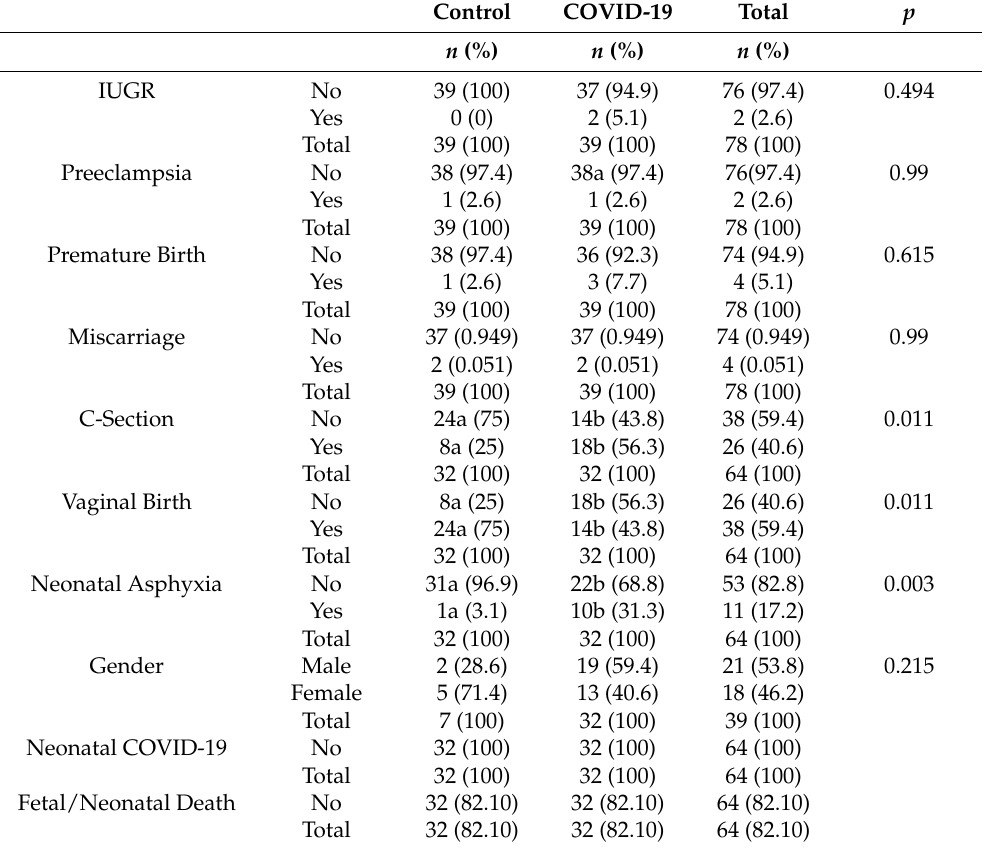
Table 5. Comparison of the variables according to the COVID-19-positive and control